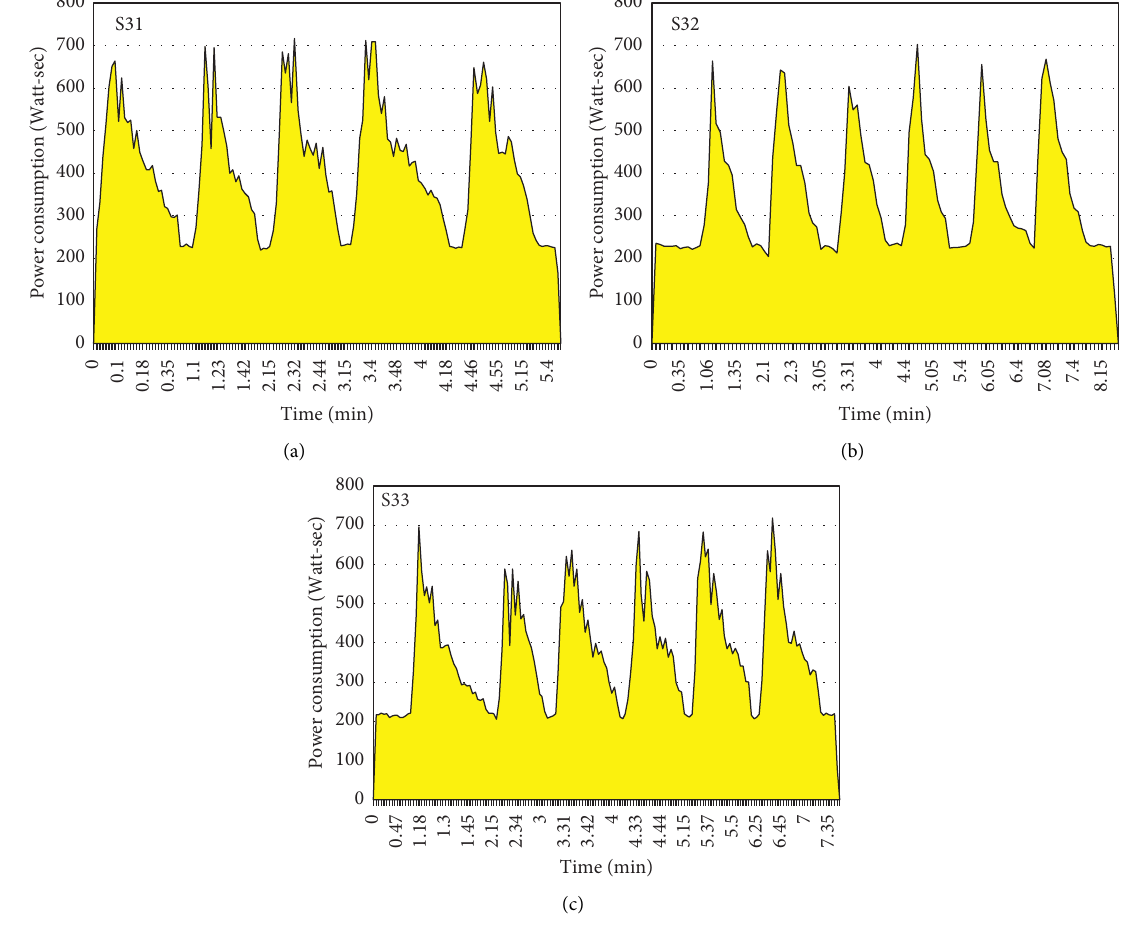
Figure 16: Power consumption curve for M40 grade concrete.